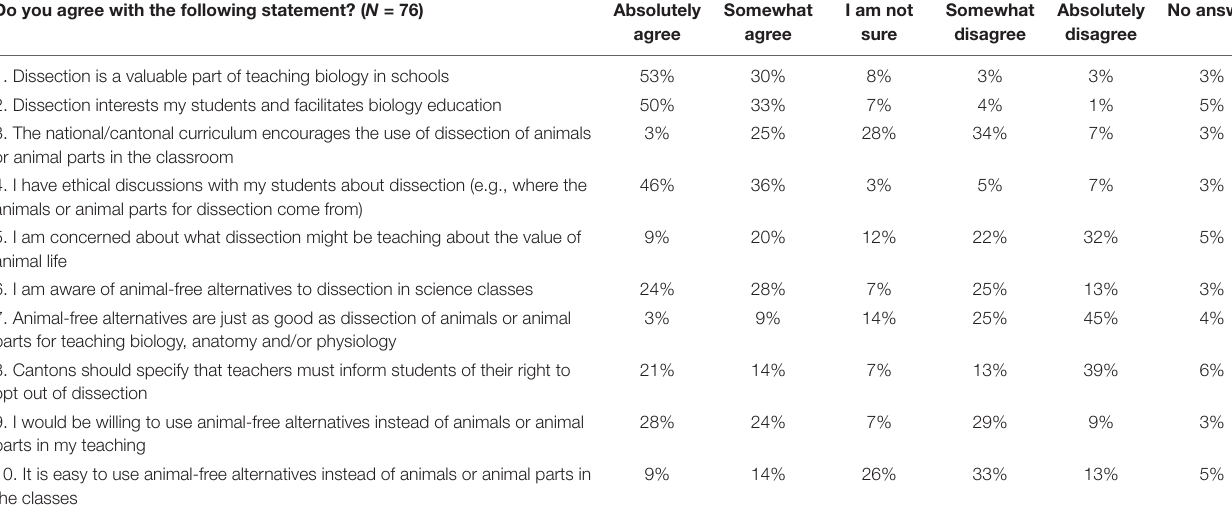
TABLE 1 | Percentage of teachers who agreed or disagreed with the following statements regarding the use of dissection and alternatives. Do you agree with the following statement? ( N =